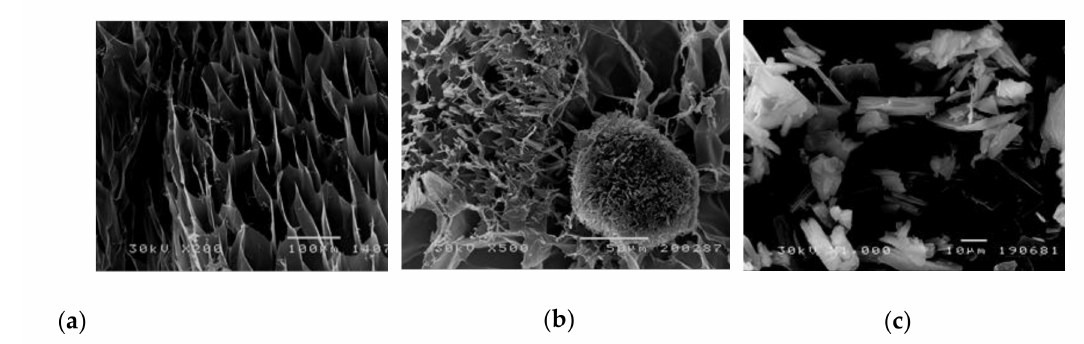
Figure 14. Scanning electron microscopy (SEM) micrographs of: ( a ) p(NIPAM-co-AA) hydrogel with 5% AA and 1.5 mol% of EGDM swollen to the equilibrium state with magnification 200 × (scale bar 100 µ m), ( b ) p(NIPAM-co-AA) hydrogel with 1.5 mol% of EGDM and incorporated biochanin A swollen to the equilibrium state with magnification 500 × (scale bar 50 µ m) and ( c ) biochanin A with magnification 1000 × (scale bar 10 µ m).